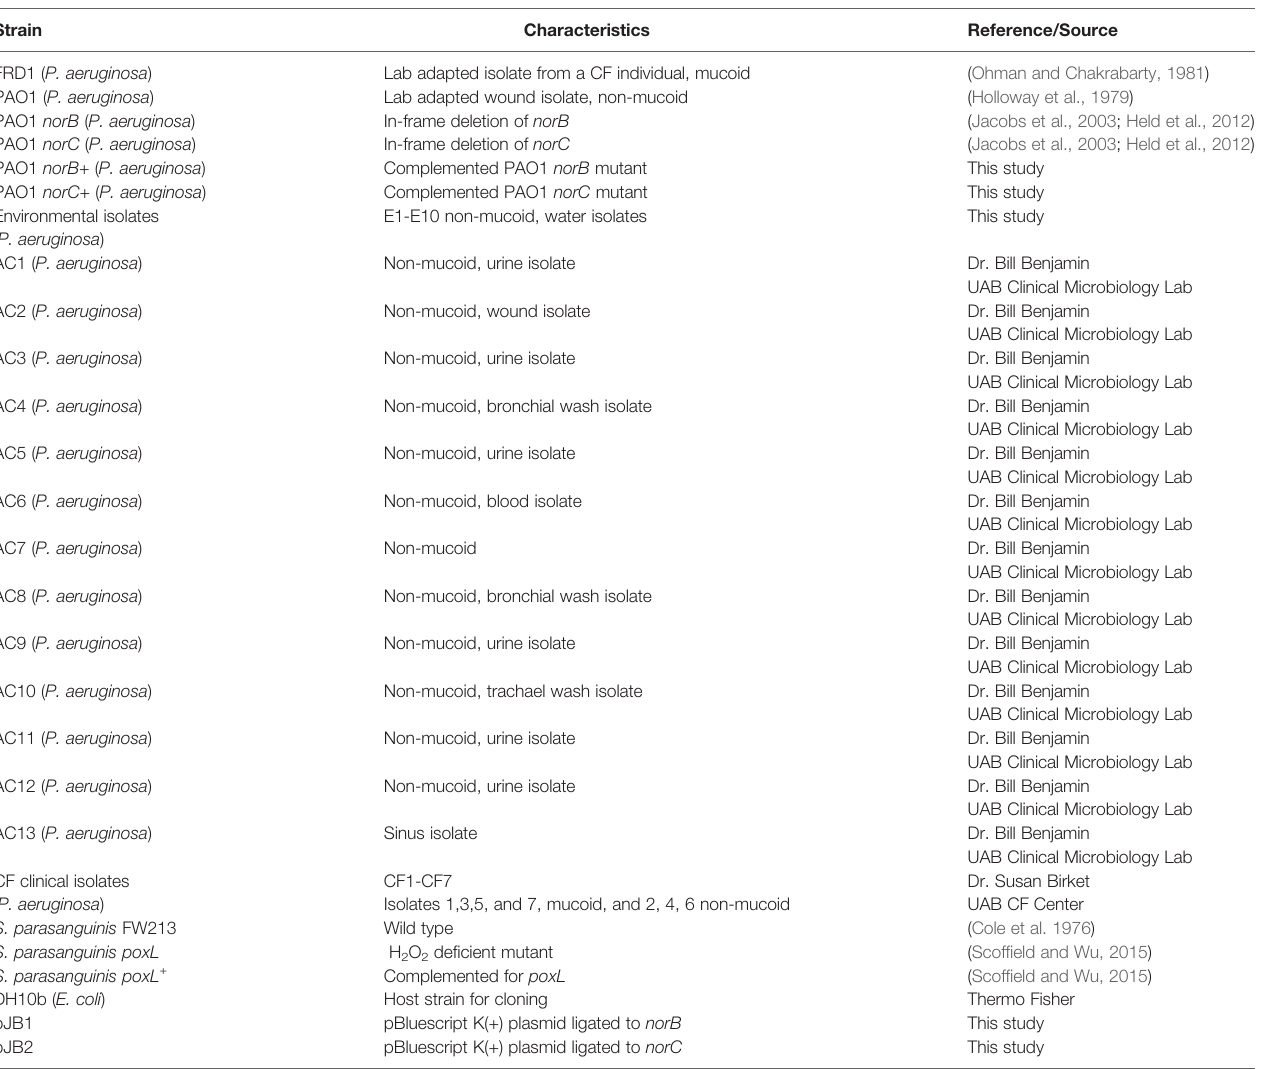
TABLE 1 | Bacterial strains and plasmids used in this study.